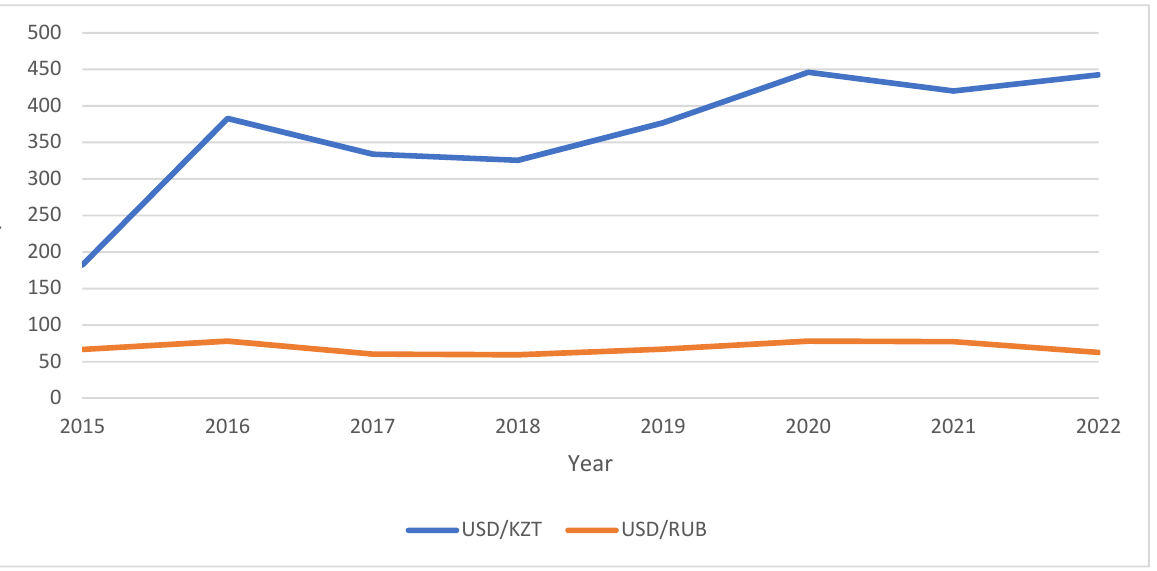
Figure 3. Dynamics of mutual trade across the EAEU countries, USD million. Source: Our own calculations based on World Bank (2022).